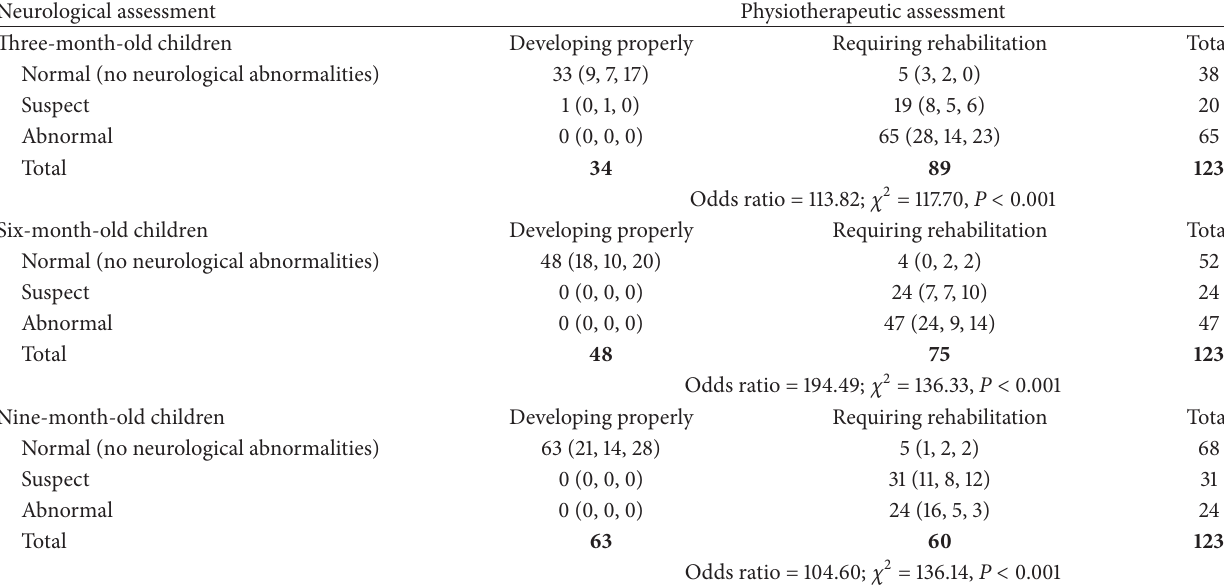
Table 1: Neurological and physiotherapeutic assessment at 3, 6, and 9 months of